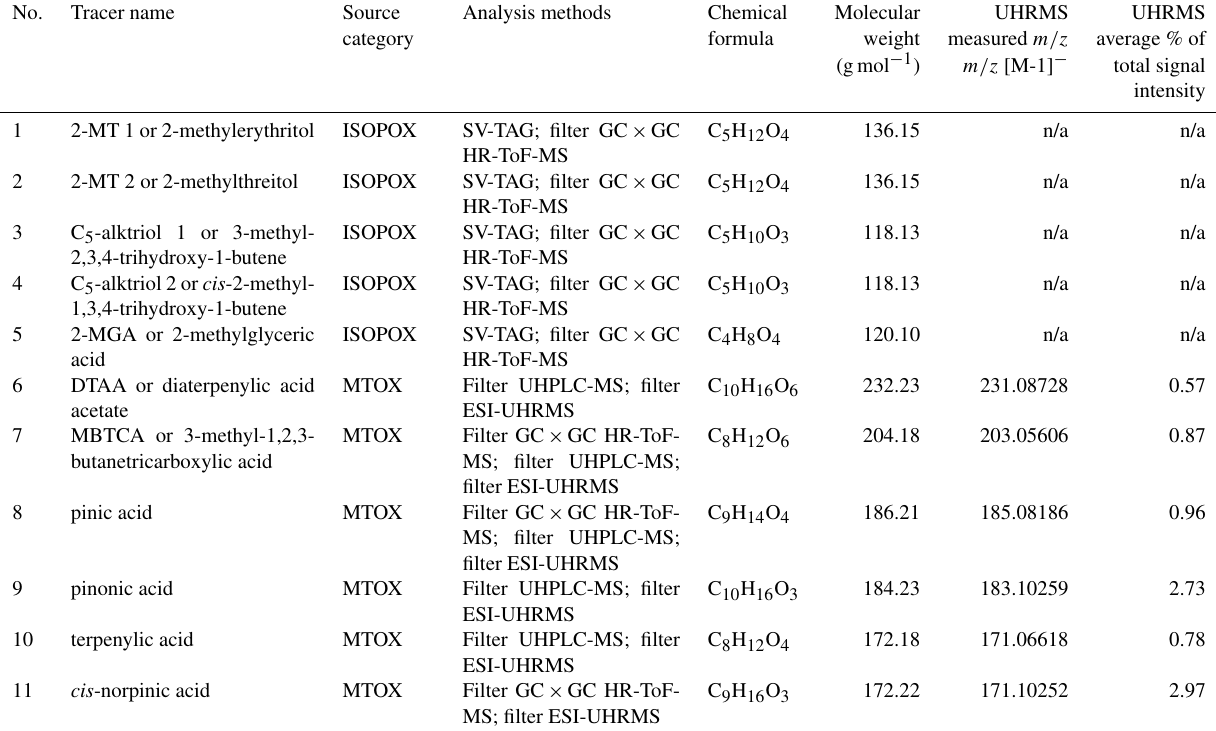
Table 3. Oxidation products from isoprene (ISOPOX) and monoterpenes (MTOXs) in central Amazonia in gas and/or particle phases. Only particle-phase measurement is presented in this study. Products marked not applicable (n/a) are not detected in the UHRMS analysis method.